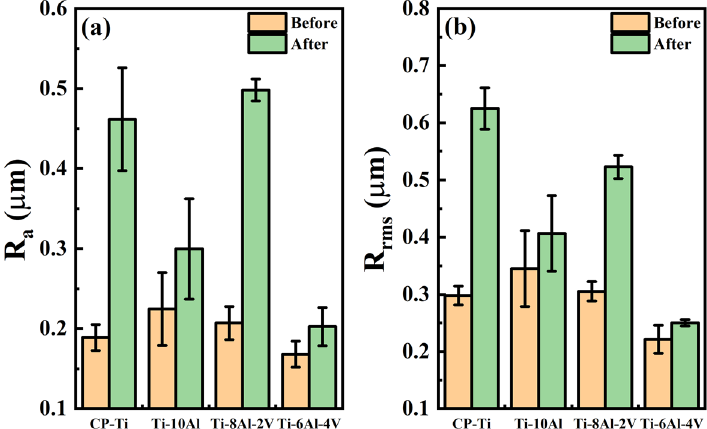
Figure 7. Roughness changes with the electrochemical analysis: ( a ) R a and ( b ) R rms